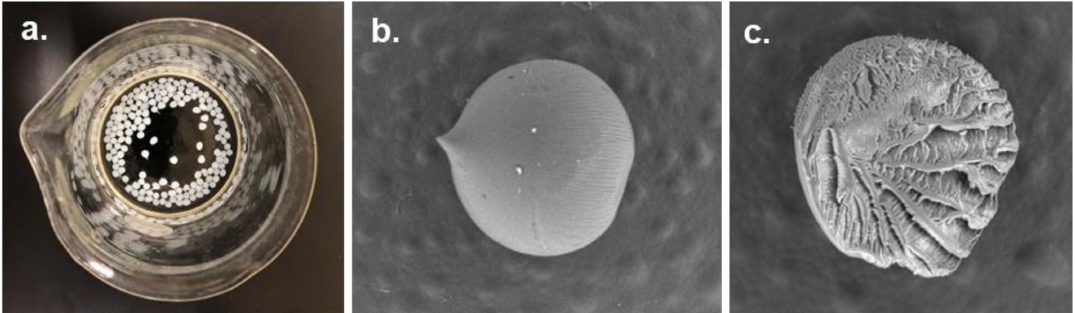
Figure 6. Cellulose beads (CBs) prepared by dropping technique. ( a ) CBs in a coagulation bath, ( b ) SEM micrograph of a CB, and ( c ) SEM micrograph of a CB